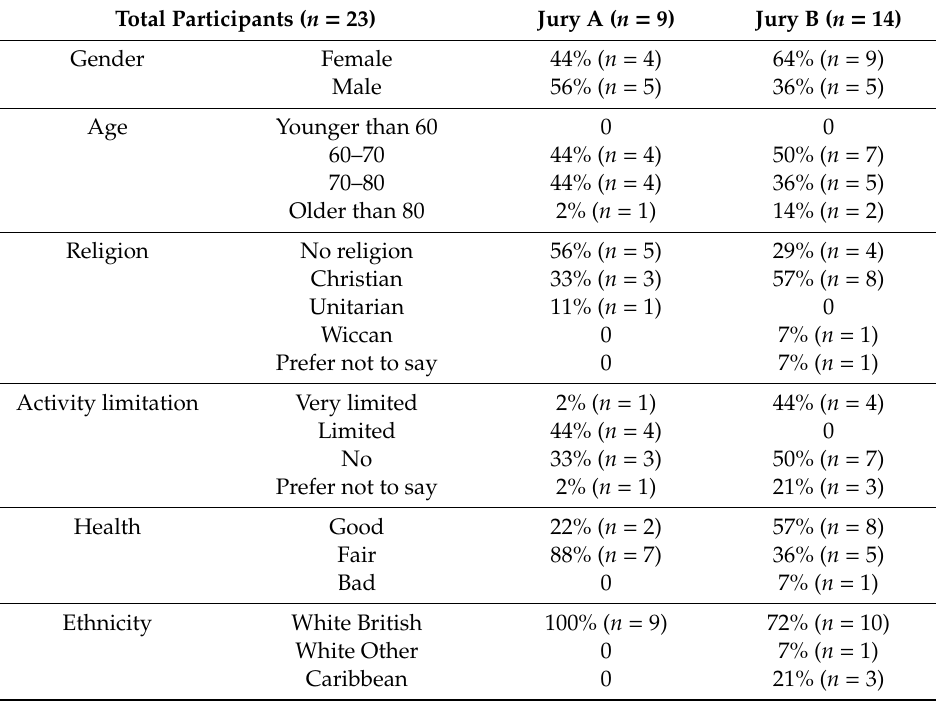
Table 2. Self-reported characteristics and beliefs of